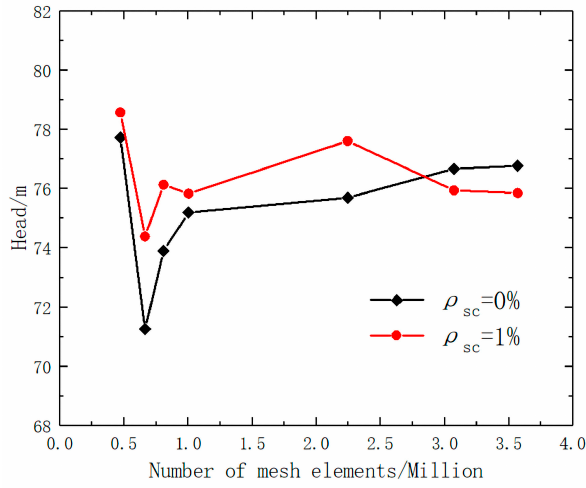
Figure 3. Change curve of the head with grid number.